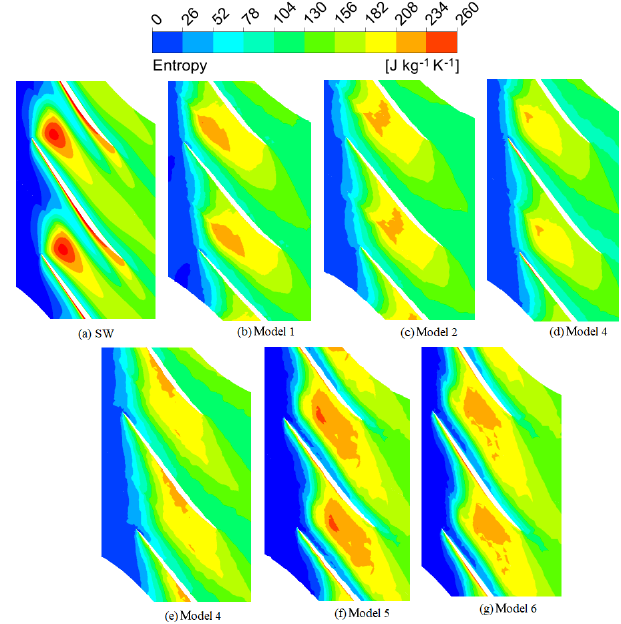
Figure 7. The contours of entropy for smooth casing and models 1–6 at 98% span close to the stall